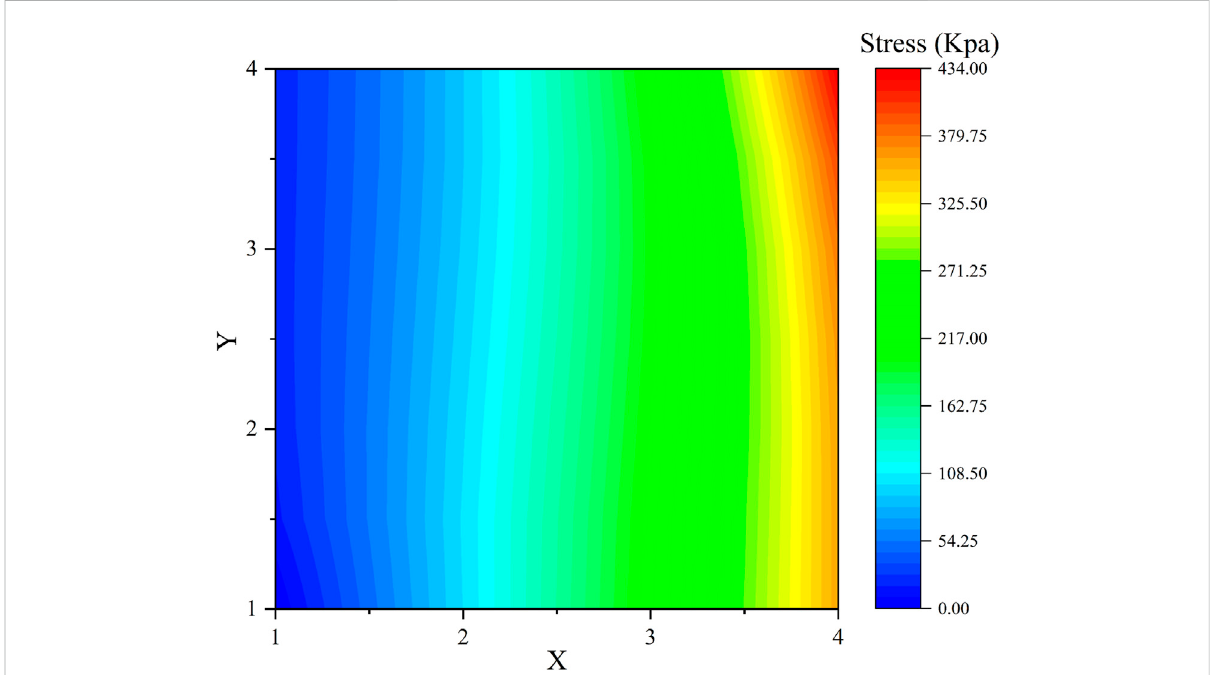
FIGURE 4 Elastic stress of VHB 4905 in the longitudinal direction with different Pre-stretch